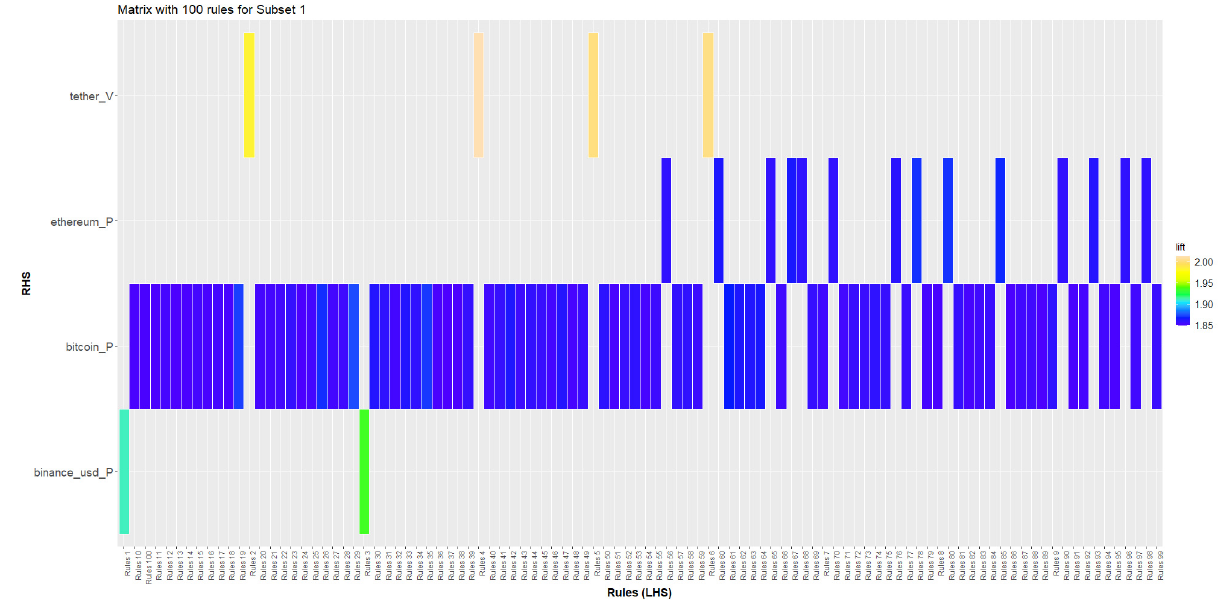
Figure 4. Matrix-based plot for Subset